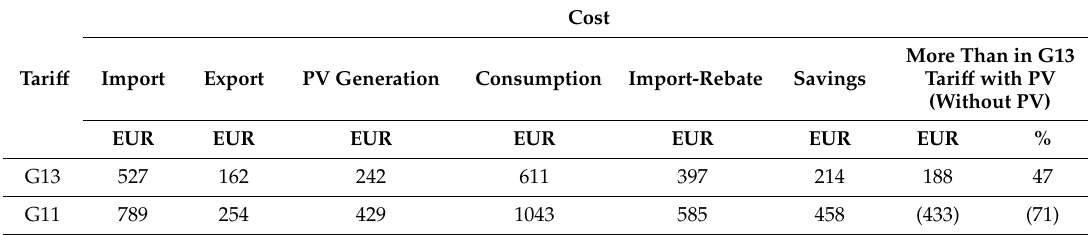
Table 13. Cost of energy exported, imported, and consumed in the building, recalculated to the G11 tari ff .